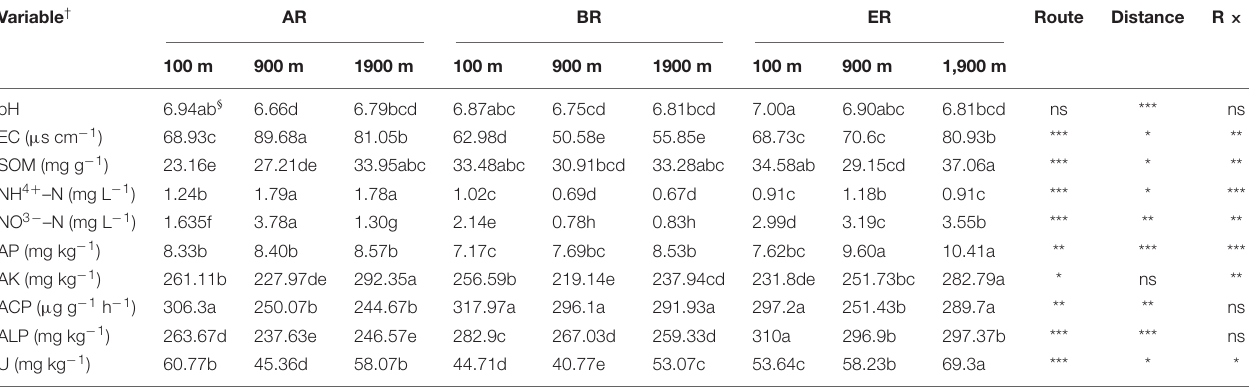
TABLE 1 | Mean values ( ± SD) of edaphic variables under different distances and routes. Variable †